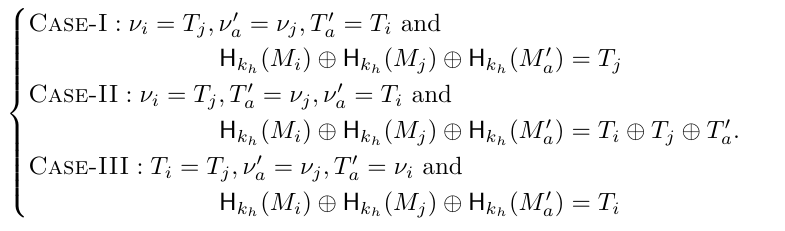
Figure 7.3: ( a ) Self Loop: when ν 0 ν 0 = T i , T 0 = ν i . Node with concentric circle denotes the verification query a a